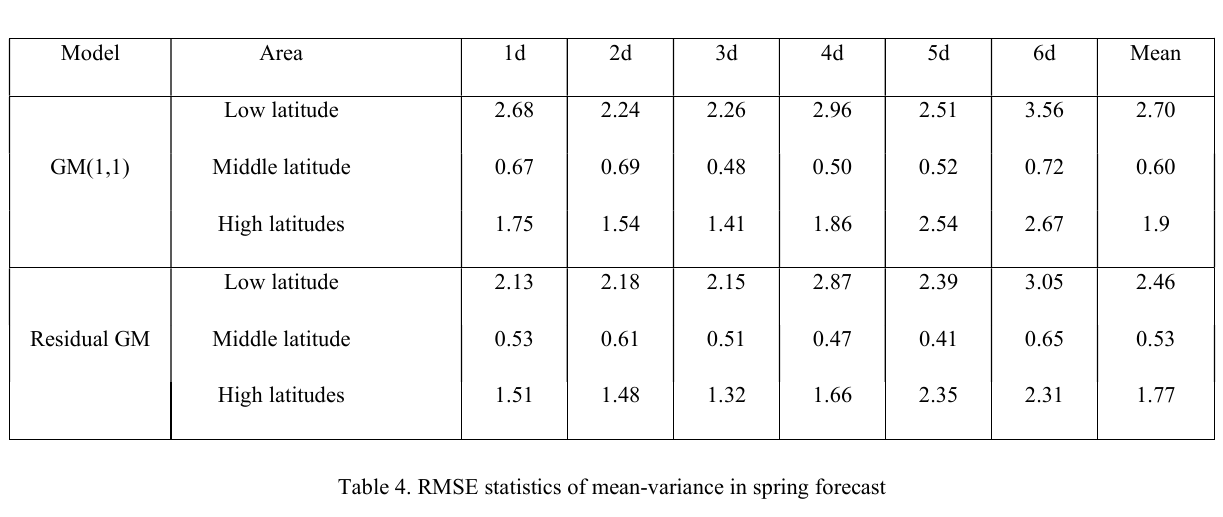
Table 3. Daily average relative accuracy of four models in high latitudes P % d, daily average relative accuracy of 91.71%. Except for 6d in Based on table 1, table 2 and table 3 prediction data to carry on spring, the average daily relative accuracy of 6d in high latitude the analysis of the daily average relative precision, after residual area is 89.22%, and the prediction accuracy of 6d in other three correction of grey model is relatively ordinary grey model in seasons is all lower than 80%, which is not ideal. prediction accuracy on ascending to a certain extent, from the point of prediction area, low latitudes and mid-latitude every seasonal forecasting accuracy remains at a high level, and the forecast accuracy of change is relatively stable, the performance good prediction accuracy of mid-latitude spring 6